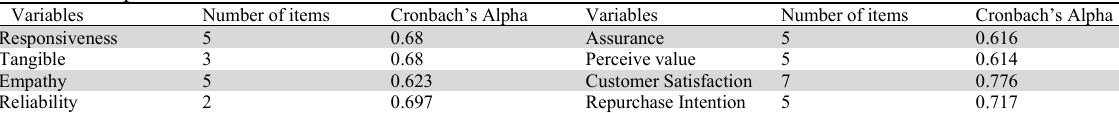
Table 2 indicated all variables satisfied the given criteria of reliability. Independent variables analysis